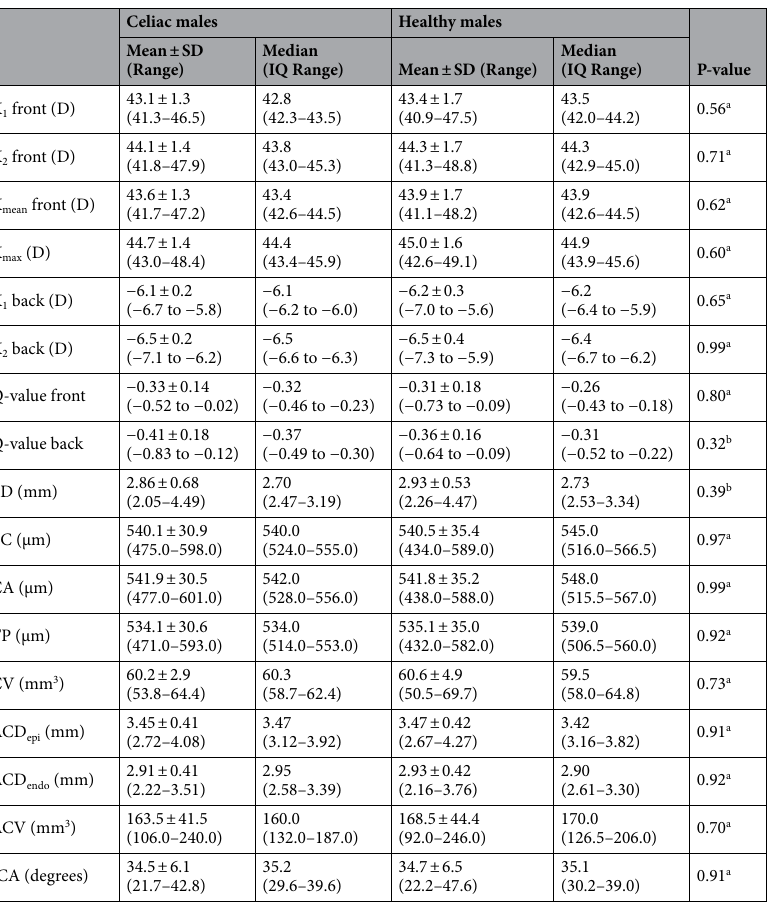
Table 5. Tomographic parameters assessed with Pentacam HR in the two male groups. a Student